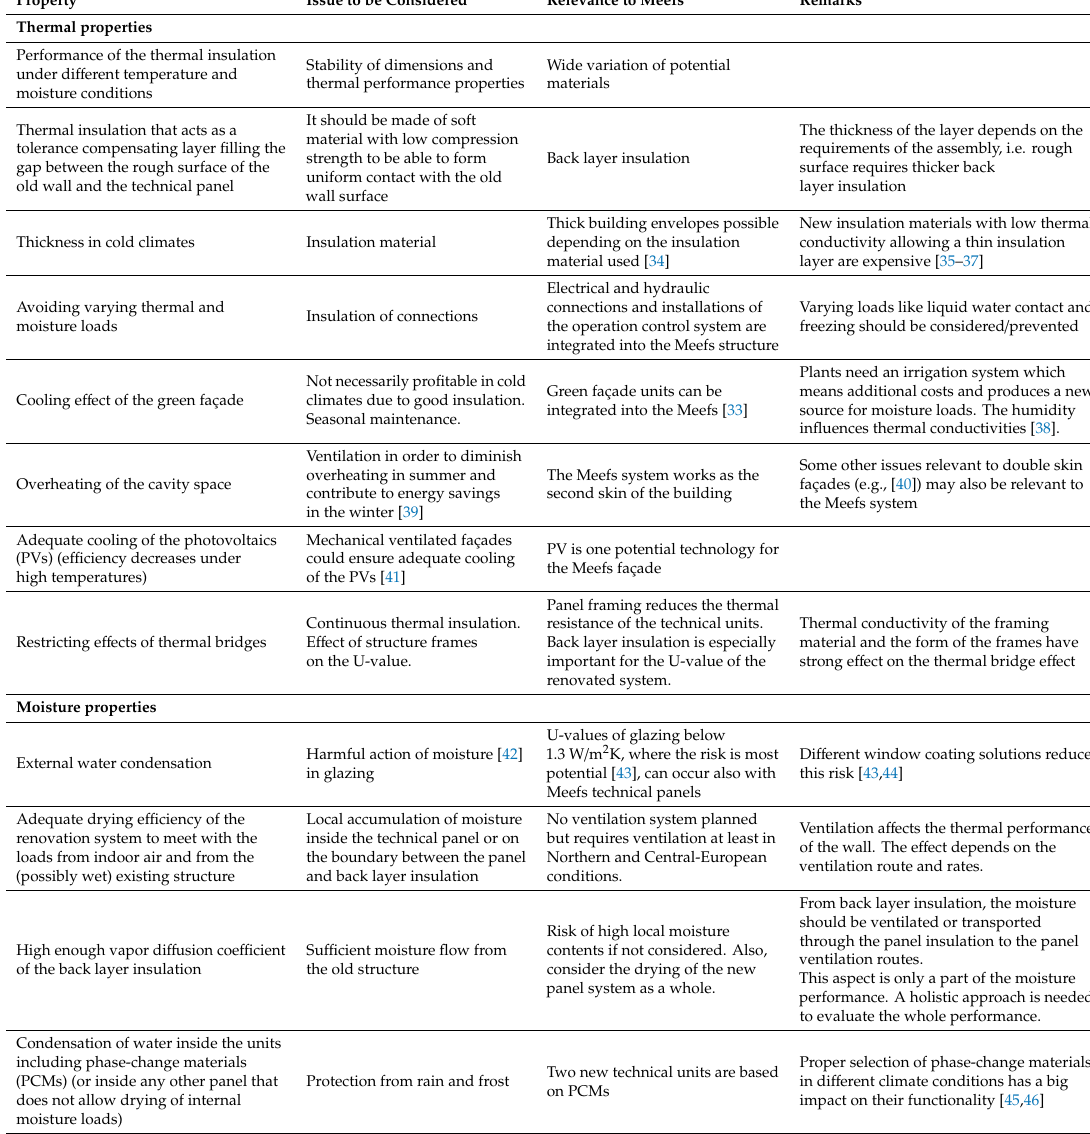
Table 1. An assessment of the thermal and moisture properties of the Meefs